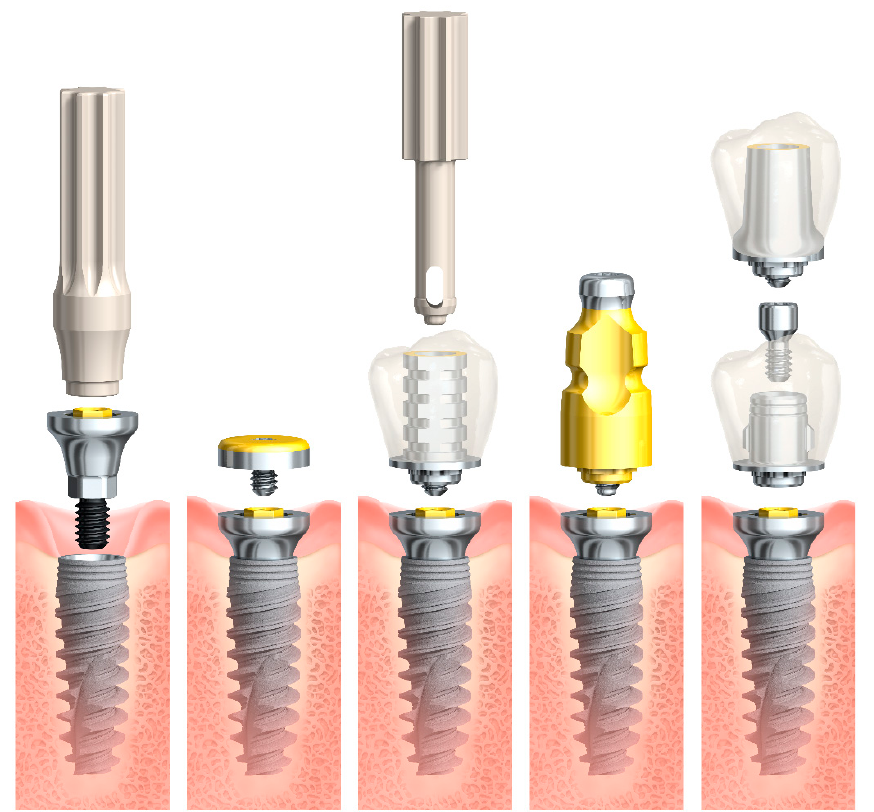
Figure 1. Prosthetic workflow of the On1 concept. From left to right: placement of the On1 base, healing cap, temporary prosthesis with temporary abutment, impression coping, and final prosthesis with either the On1 esthetic abutment or universal abutment (image courtesy of Nobel Bio- care).